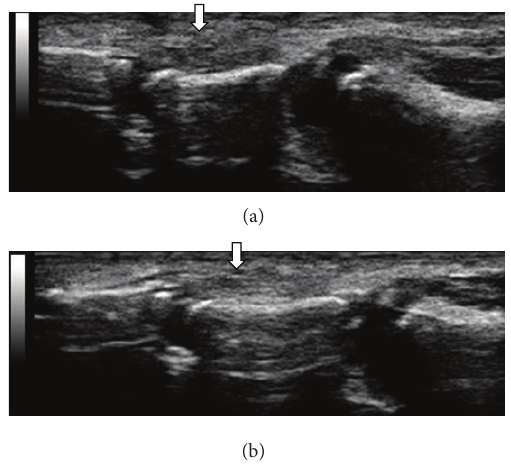
Figure 2: (a) Findings of the ultrasonography at three months after the surgery: it showed the edematous FPL tendon with the hypo- echoic lesion. The arrow showed the suture site of the FPL tendon. (b) Findings of the ultrasonography at one year after the surgery: it showedtheuniformthicknessoftherepairedFPLtendon.Thearrow showed the suture site of the FPL